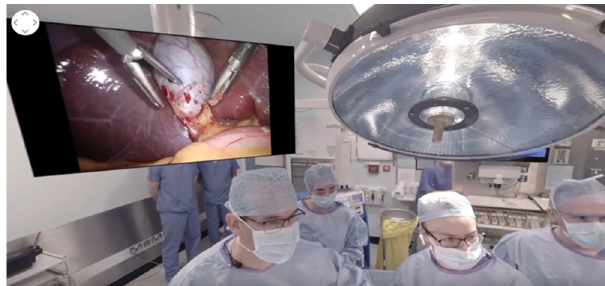
Figure 2. Sample screen (intra-operative view of laparoscopic cholecystectomy). Laparoscopic Chol- ecystectomy 360 Video—Professor Arnie Hill (Surgical Affairs, RCSI, March 2017).